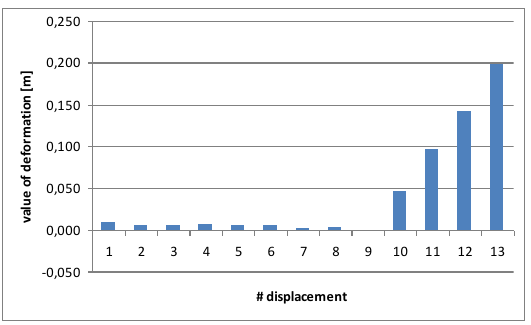
Figure 14. Vertical displacement detection [m] 3.3 Movement determination with a mass-market receiver The mass market receiver is equipped with its own small antenna, but the phase centre variations (PCV) are unknown. In order to place the antenna over a known point, a special small ground plane was created (Figure 13), which allows precise location. To determine the PCV of the patch antenna, a static measurement of 3 hours was realized, calculating the coordinates of the antenna as the difference between the were applied to the estimated coordinates during the test.